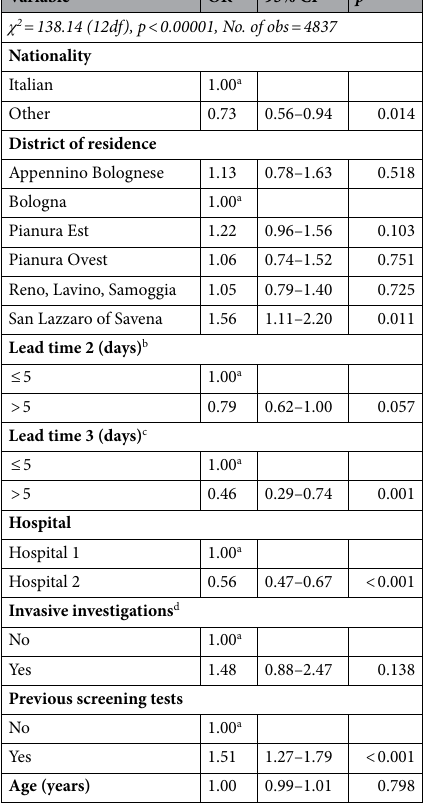
Table 2. Multiple logistic regression analysis results examining re-attendance according to several explanatory variables. a Reference category. b Lead time between I level diagnostic conclusions and II level investigations. c Lead time between II level investigations and II level diagnostic conclusion. d Invasive investigations involved cytological and histological